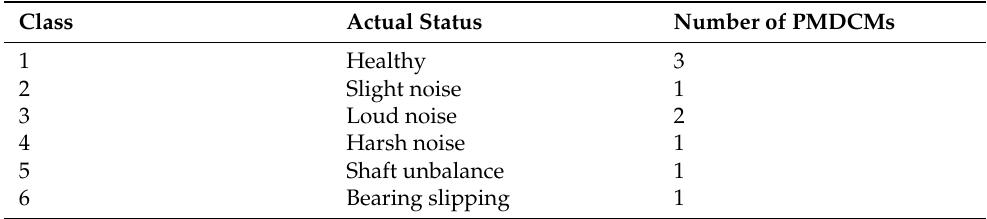
Table 3. Categorization for healthy and faulty PMDCMs.